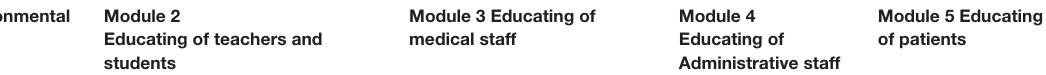
TABLE 5 | Program scope and